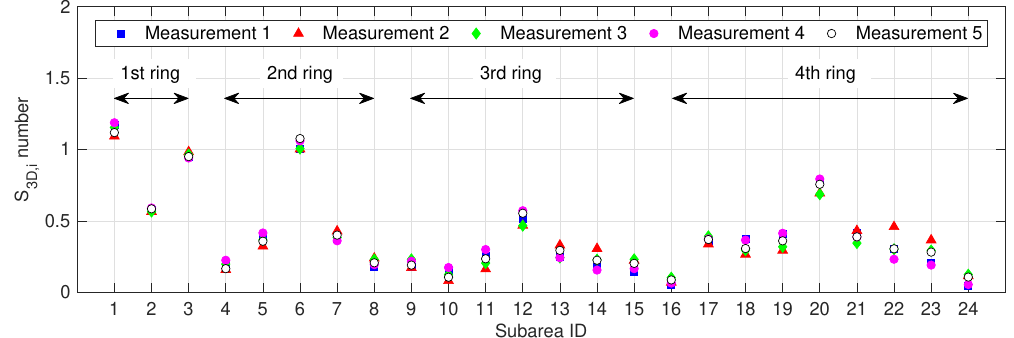
Figure 10. Results of repeated damage measurements for the case